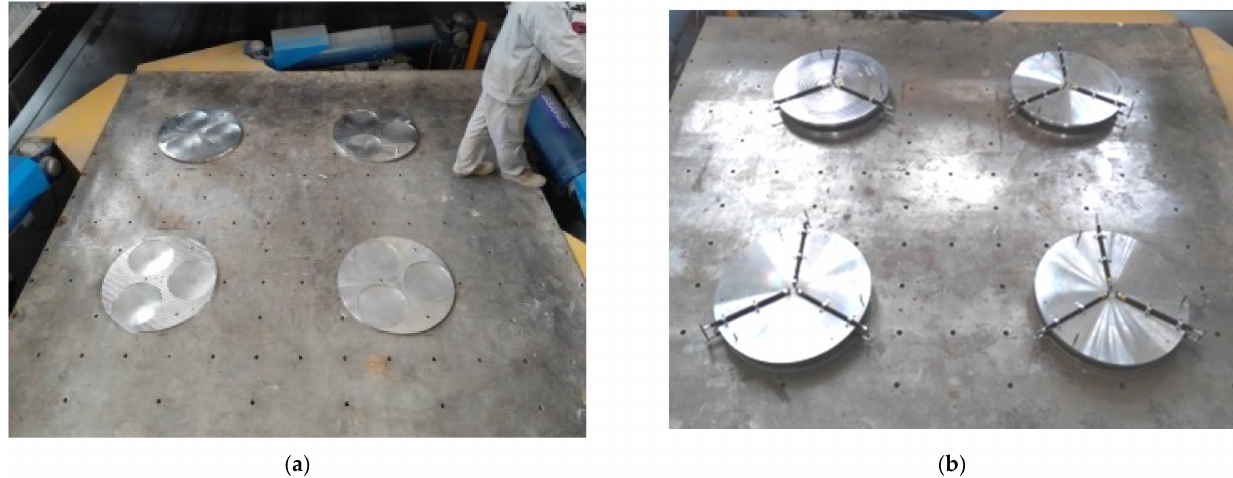
Figure 15. ( a ) Shake table and ( b ) test models